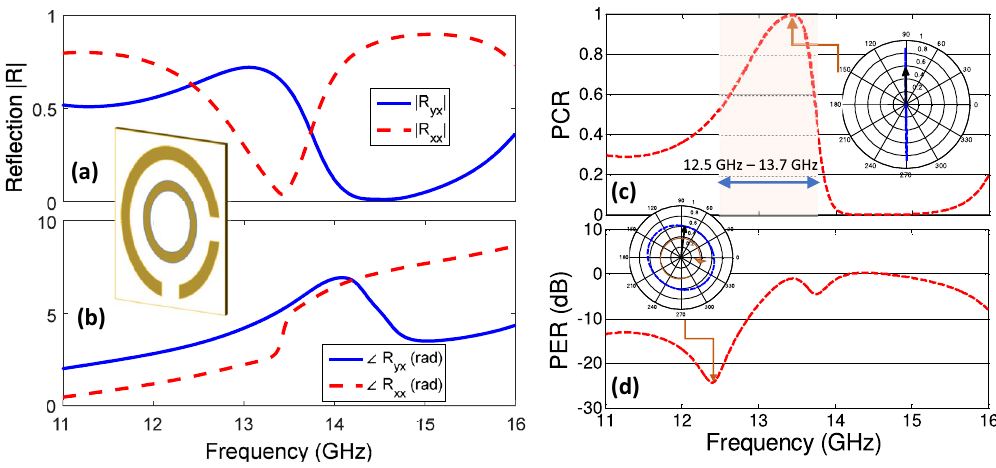
Figure 3. ( a ) Magnitude and ( b ) phase of reflection coefficients for co- R xx and cross R yx polarized components for co-direction chiral reflecting metasurface. ( c ) Polarization extinction ratio in dB for co-direction chiral reflecting metasurface. Inset for figure ( c ) and ( d ) shows the contour of time varying orientation of reflected electric field vector at resonance frequency for cross and circular